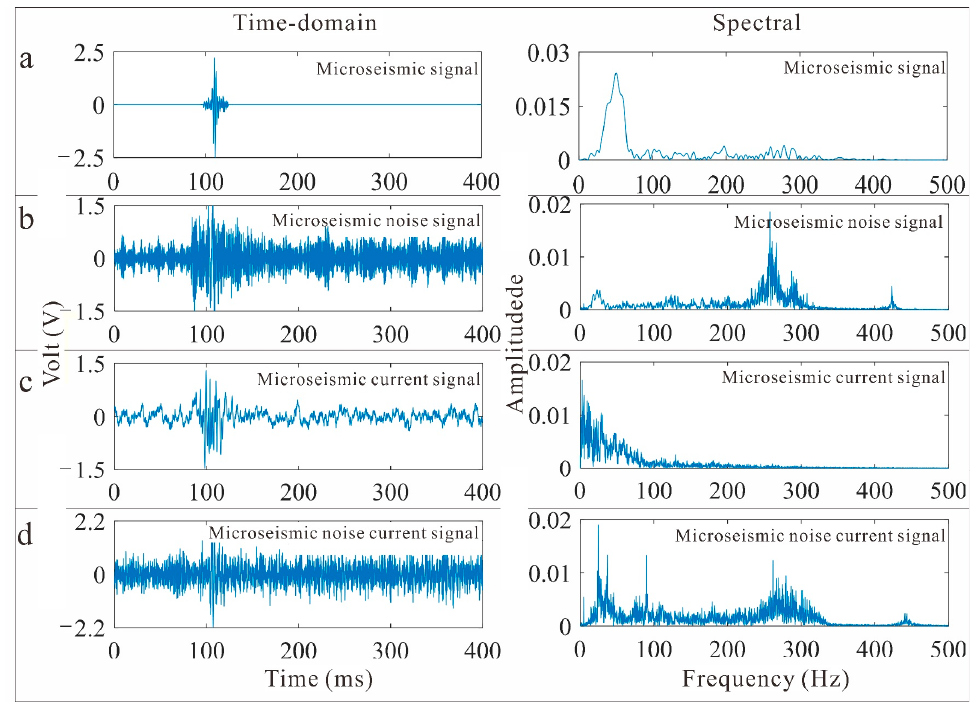
Figure 2. Waveforms of different signals: ( a ) microseismic signal, ( b ) microseismic noise signal, ( c ) microseismic current signal, ( d ) microseismic noise current signal.